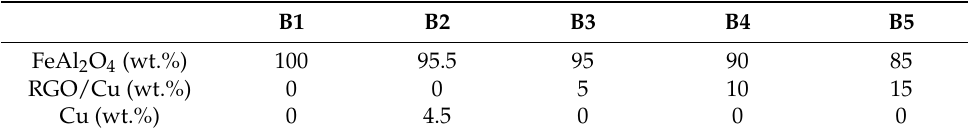
Figure 1. The description of the composite powder preparation process. Table 1. The summarized content of